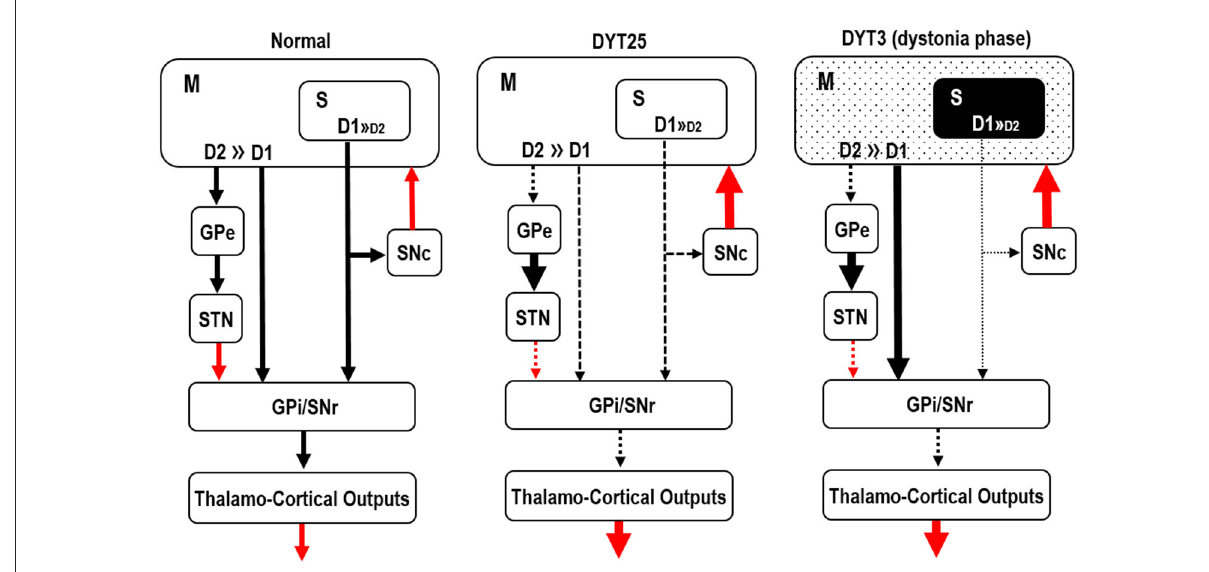
FIGURE1 Hypothetical functional anatomy of the basal ganglia in DYT25 and DYT3. A schematic representation of the basal ganglia circuit is presented. Black and red arrows indicate inhibitory and excitatory striatal output projections, respectively. The striatum consists of two functional subdivisions: striosome (S) and matrix (M) compartments. Three major pathways are emphasized: the direct pathway originating from medium spiny striatal projection neurons (MSNs) possessing D1-receptors (D1), the indirect pathway from MSNs possessing D2-receptors (D2), and the striosomal pathway from the striosome (S) compartment, which is heavily enriched in D1-receptors. In DYT 25, mutations in the GNAL gene cause a loss of function of G α olf, leading to reduced activity of D1-receptors in striosomal pathway MSNs. In DYT3, severe degeneration of striosomal MSNs that possess D1-receptors is found in the early disease phase when dystonia symptoms occur (dystonia phase). M, matrix compartment; S, striosome compartment; GPe, globus pallidus externa; STN, subthalamic nucleus; SNc, substantia nigra pars compacta; GPi, globus pallidus internus; SNr, substantia nigra pars